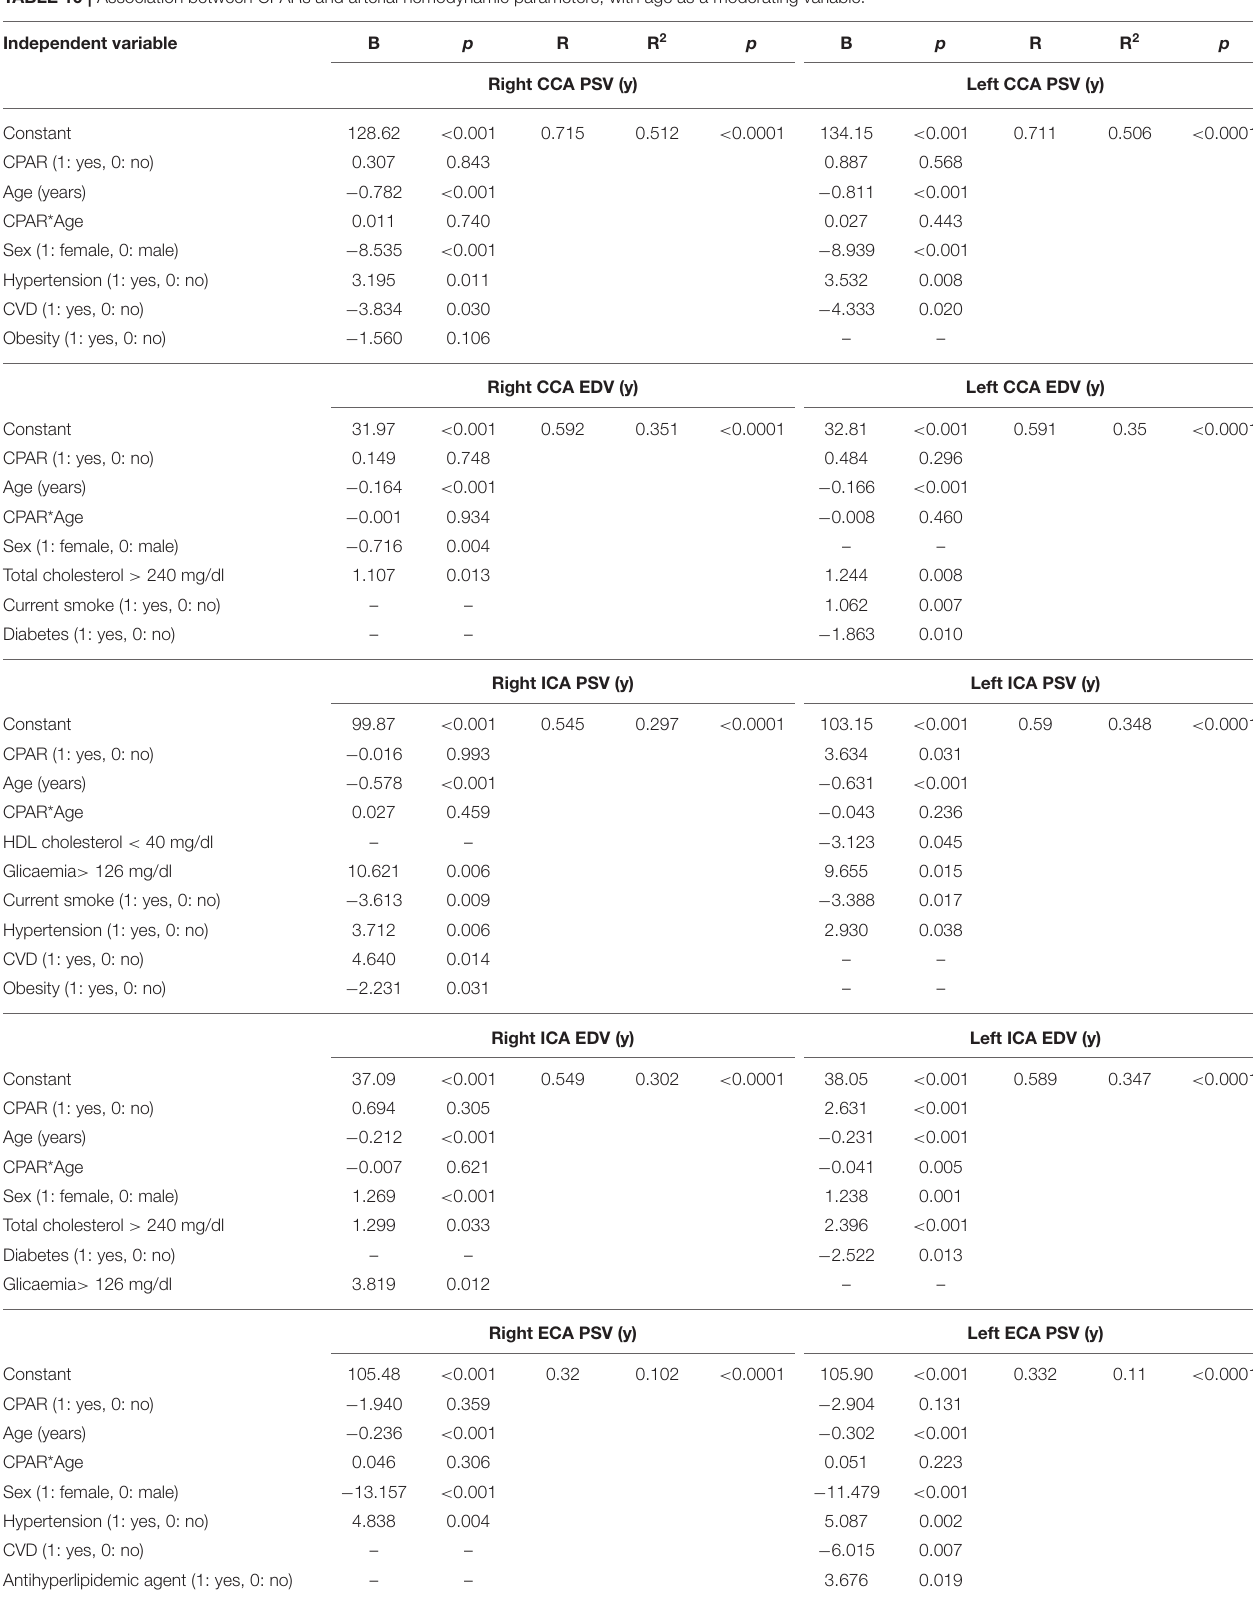
TABLE 10 | Association between CPARs and arterial hemodynamic parameters, with age as a moderating variable. Independent variable